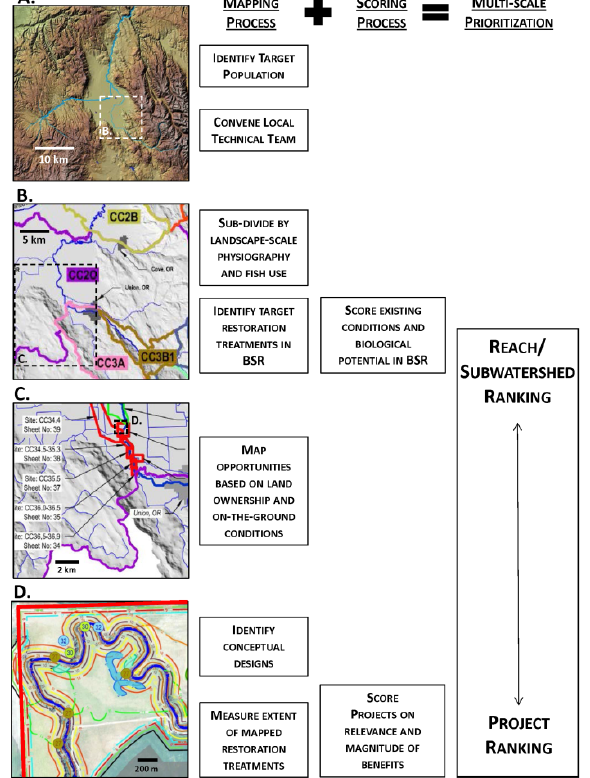
Figure 9. Conceptual diagram and flow chart depicting the Atlas prioritization framework, as led by BPA for the restoration of habitat for the benefit of target salmonid populations in the Columbia Basin (example here is from the Catherine Creek watershed, a tributary to the Grande Ronde River in northeast Oregon; see Figure 3). The map panels on the left depict the nested, scale-dependent hierarchy of mapping, while the text blocks outline the parallel processes of mapping, scoring and ranking. The vertical position of each step in the process corresponds to the spatial scale for the given step. Within a chosen region ( A ), local experts divide the watershed of interest into biologically-significant reaches (BSRs) ( B ) with relatively consistent geomorphology and fish use, and which are then scored on the basis of existing conditions and biological potential. Potential restoration actions within each BSR are also scored, given known opportunities and constraints imposed by land ownership and valley type ( C ). Conceptual designs of potential restoration actions are then mapped for each opportunity ( D ).